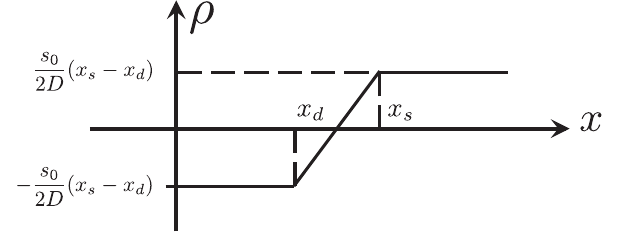
FIG. 9. The steady-state density distribution, Eq. (A15), obtained by the integration in Eq. (A12) with a source and drain located at x ¼ x and x ¼ x as represented by the injection rate, s d Eq.